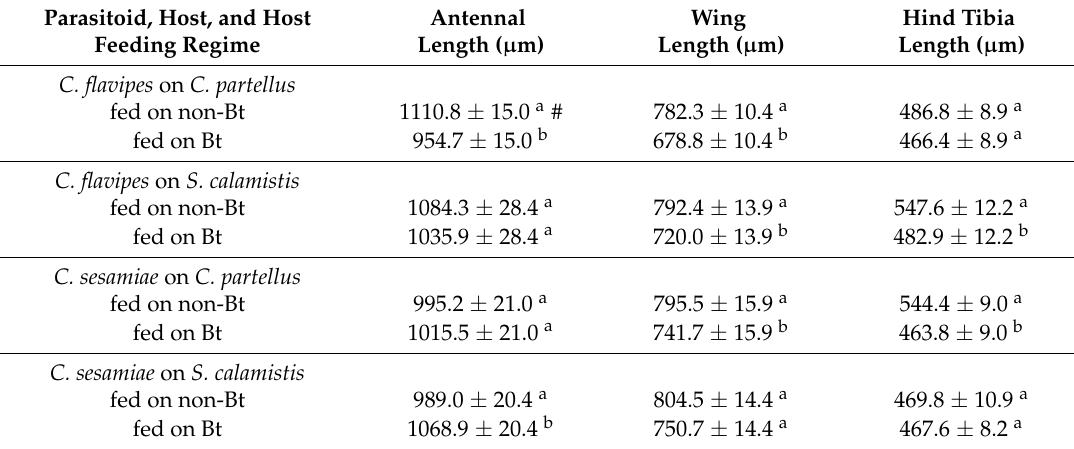
Table 1. Antennal length, wing length, and hind tibia length (Mean ± SE) of the parasitoids Cotesia flavipes and Cotesia sesamiae developed on the stem borers Chilo partellus and Sesamia calamistis on Bt maize vs. non-Bt maize for 24 h ( n = 20